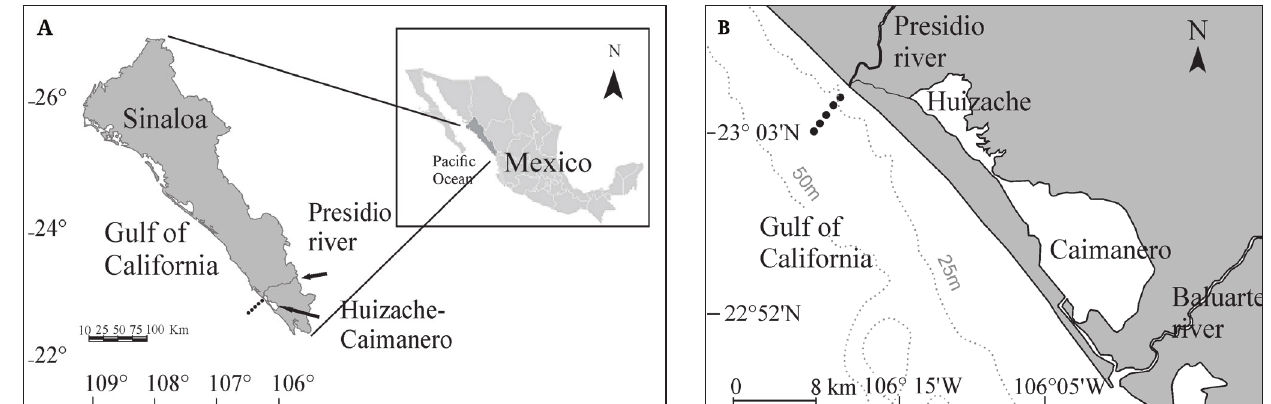
FIGURE 1 | A. Map of the study area, nearshore waters in front of the Huizache-Caimanero estuarine system, located in the southeast Gulf of California, Sinaloa, Mexico. Sampling sites are indicated by black circles. B. Detail of the study area and sampling sites located in front of the Presidio River